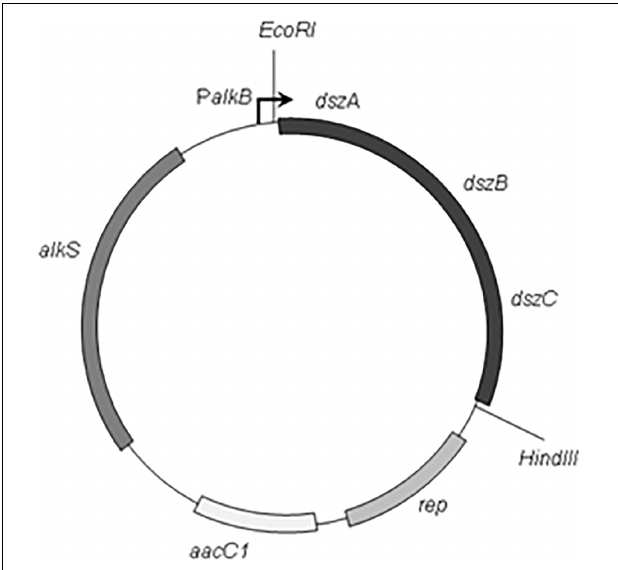
FIGURE 1 | Schematic map of the plasmid pCom8ABC. Restriction sites and structural genes are indicated (The Eco RI and Hin dIII restriction sites in multiple Cloning Site of vector pCom8 were located on upstream and downstream of dsz cluster, dszA, dszB, and dszC encoding dibenzothiophene desulfurization enzymes from Rhodococcus sp. FUM94; aacC1, gentamicin resistance gene; alkS, the positive regulatory gene of promoter PalkB; rep, the Pseudomonas origin of